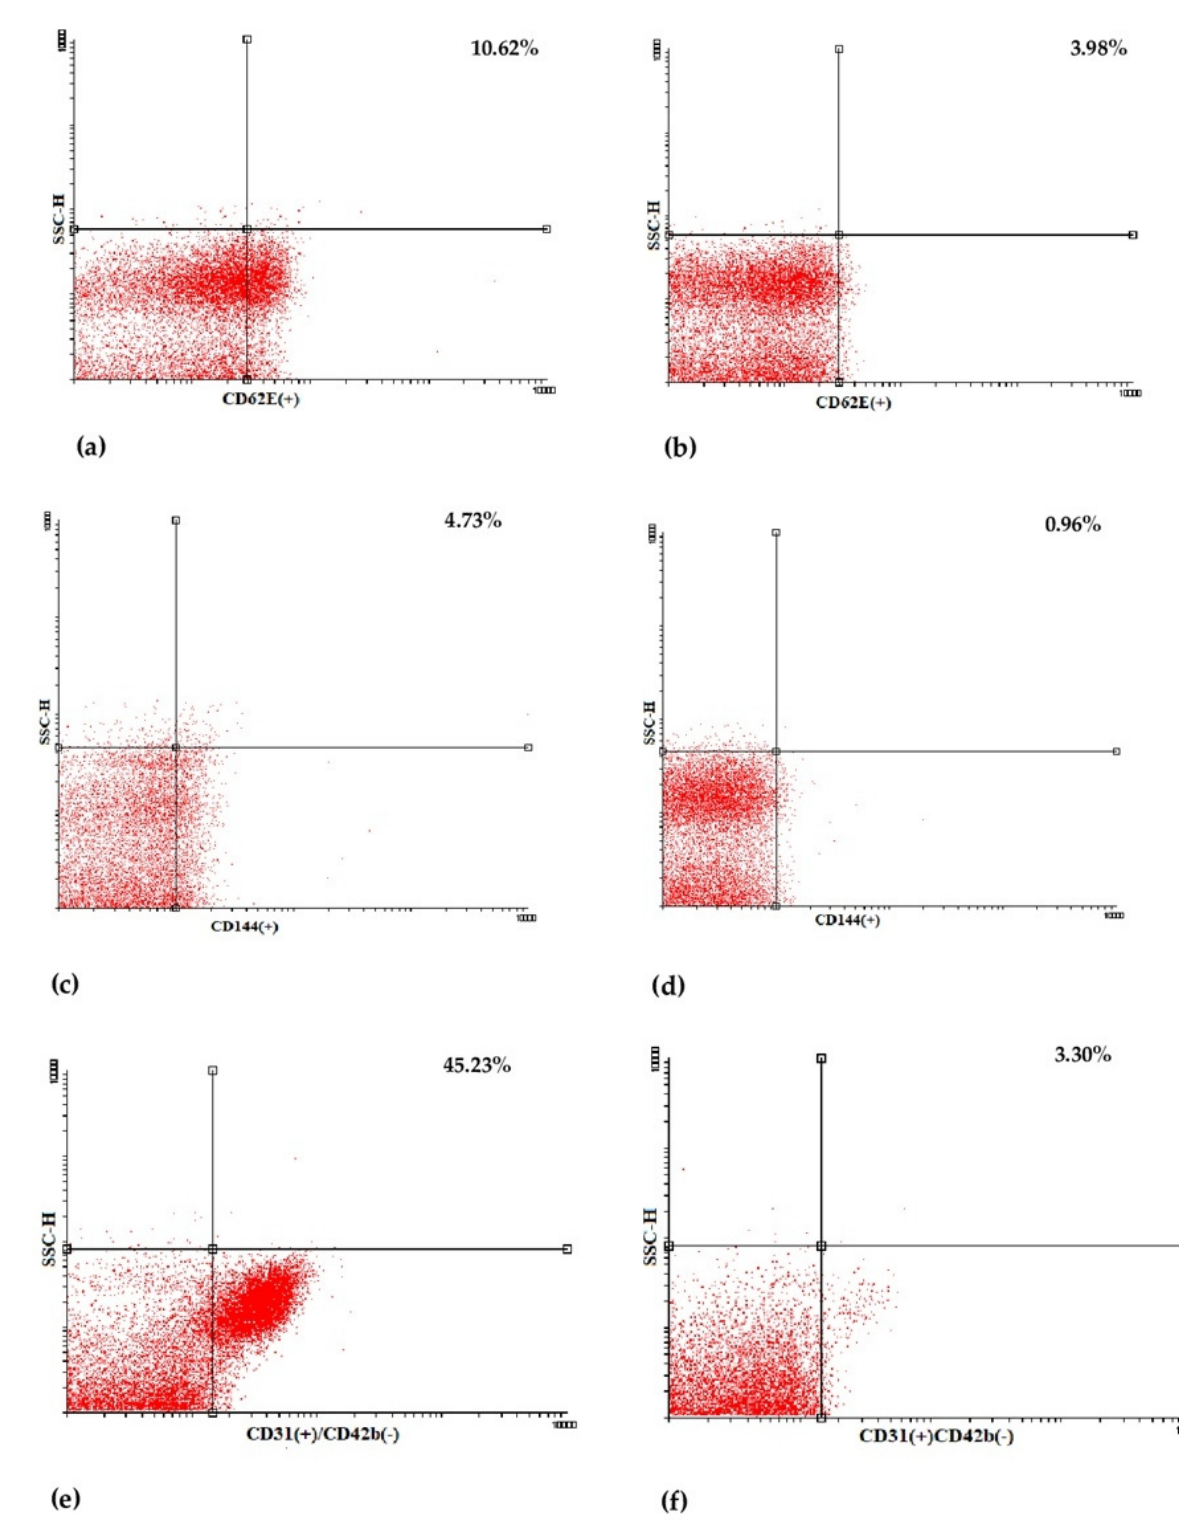
Figure 2. Representative dot plots of flow cytometric determination of CD62E(+) ( a , b ), CD144(+) ( c , d ) and CD31(+)/CD42b(-) ( e , f ) endothelial microparticles (EMPs) in a preterm-born child ( left ) and in a full-term-born child ( right ). SSC-H: side scatter height.